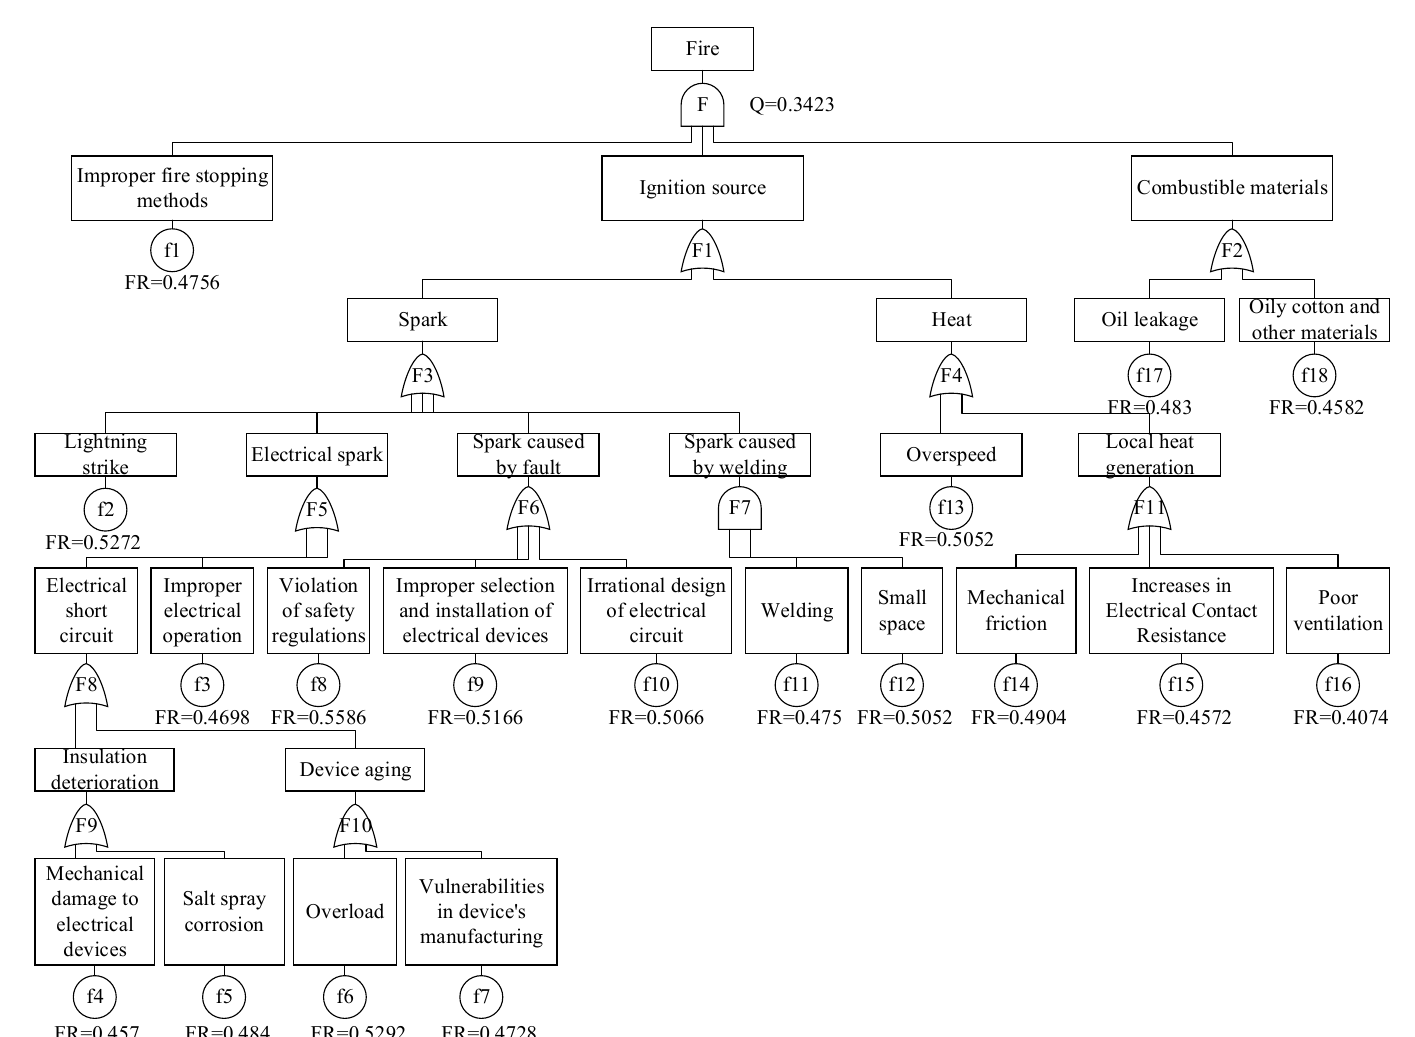
Figure 6. Fault tree analysis model for fire risk of the offshore wind farm.